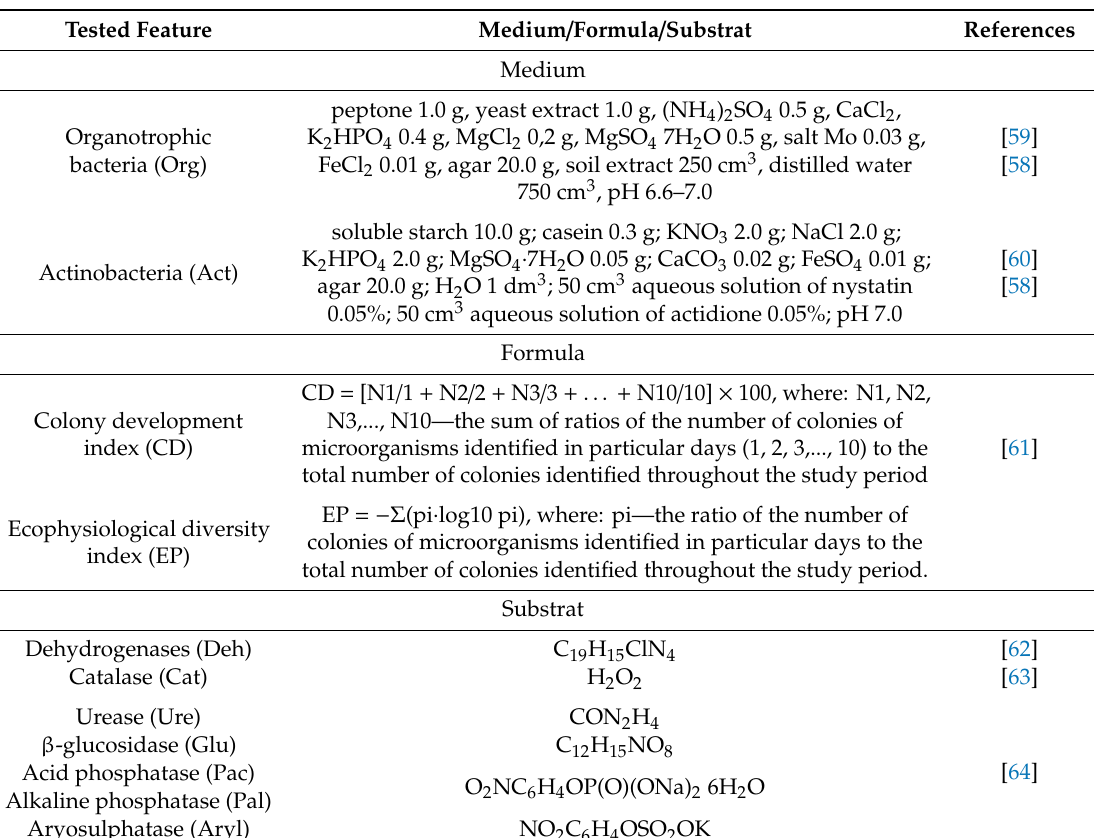
Table 3. Parameters for determining the number of organotrophic bacteria and actinobacteria, calculating colony development index and ecophysiological diversity index, and determining enzyme